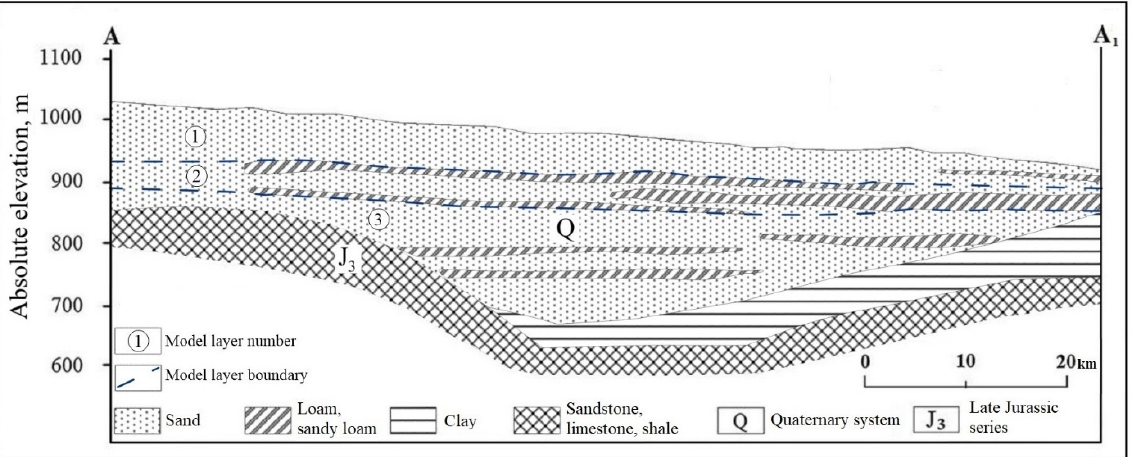
Figure 2. Geological cross section of the study area from southwest to northeast (Figure 1). Modified from Xi et al. [12].